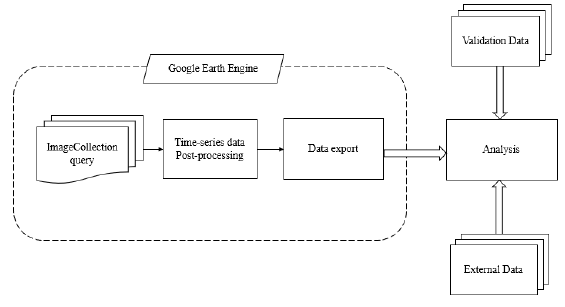
Figure 2 General overview of the